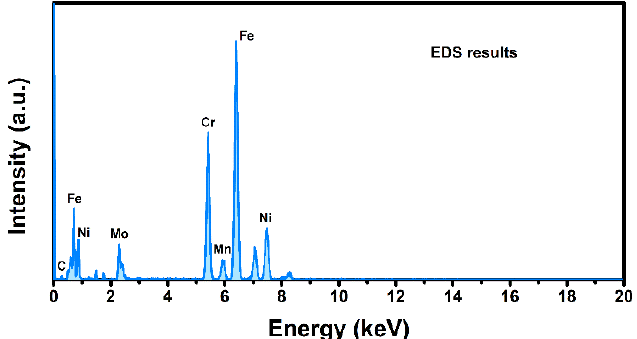
Figure 8. EDS results of the sample.